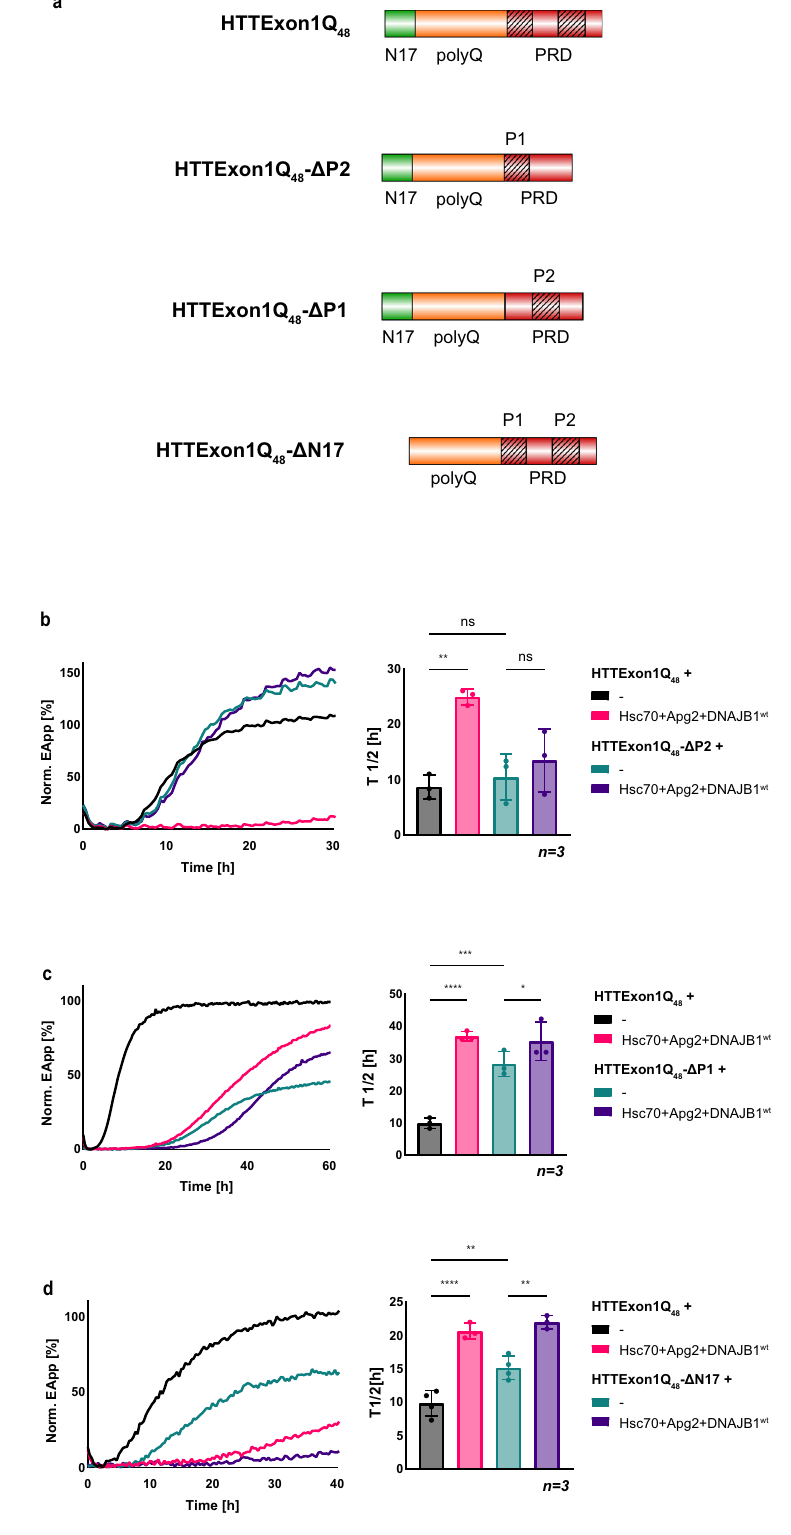
Fig. 3 | DNAJB1 interacts with the P2 region within the PRD of HTTExon1Q 48 . Hsc70, Apg2, and DNAJAB1 wt . The graphs are representative results of three inde- a Schematic representation of HTTExon1Q 48 with its N17, polyQ,and PRD domains pendent experiments and one-way ANOVA analyses of the half-life ( T 1/2 ) of and the three variants, HTTExon1Q 48 - Δ P2 that lacks the P2 region, HTTExon1Q 48 - HTTExon1Q 48 - Δ P2, HTTExon1Q 48 - Δ P1, and HTTExon1Q 48 - Δ N17 compared to Δ N17 with a missing N17 domain. Δ P1 lacking the P1 region, and HTTExon1Q 48 - b – d FRETassayof theaggregationof( b )HTTExon1Q 48 - Δ P2,( c )HTTExon1Q 48 - Δ P1, and ( d ) HTTExon1Q 48 - Δ N17 compared to HTTExon1Q 48 and upon addition of